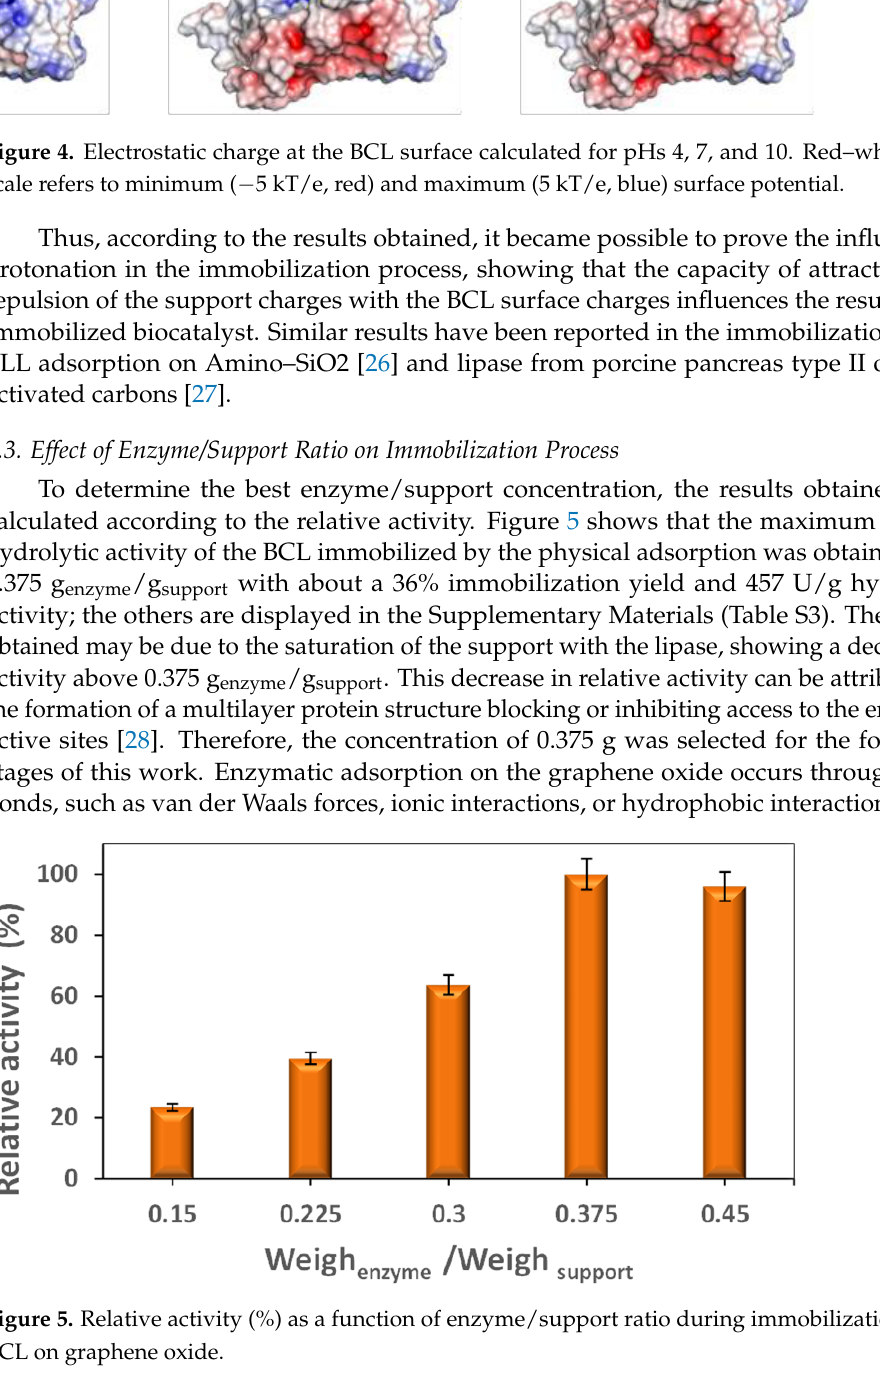
BCL on graphene Figure 5. Relative activity (%) as a function of enzyme/support ratio during immobilization of the BCL on graphene oxide.